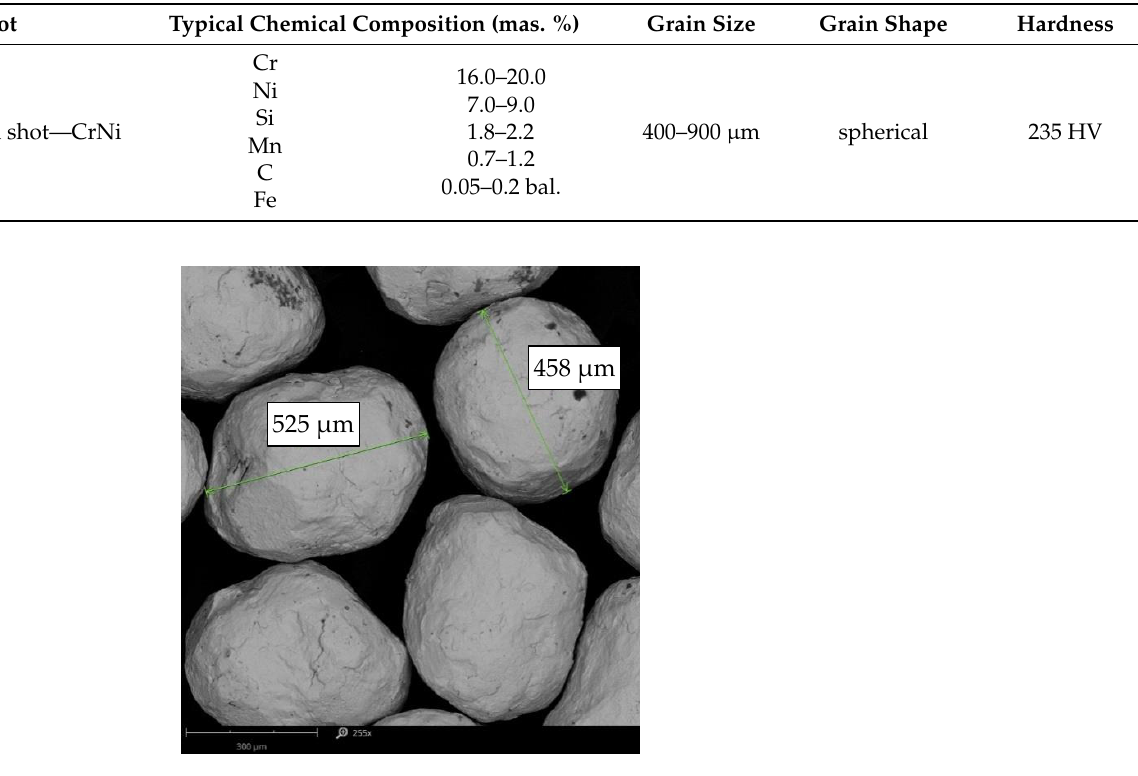
Figure 1. Morphology of stainless steel shot, SEM. Table 3. Notations of the specimens used in the experiment and shot peening variables.